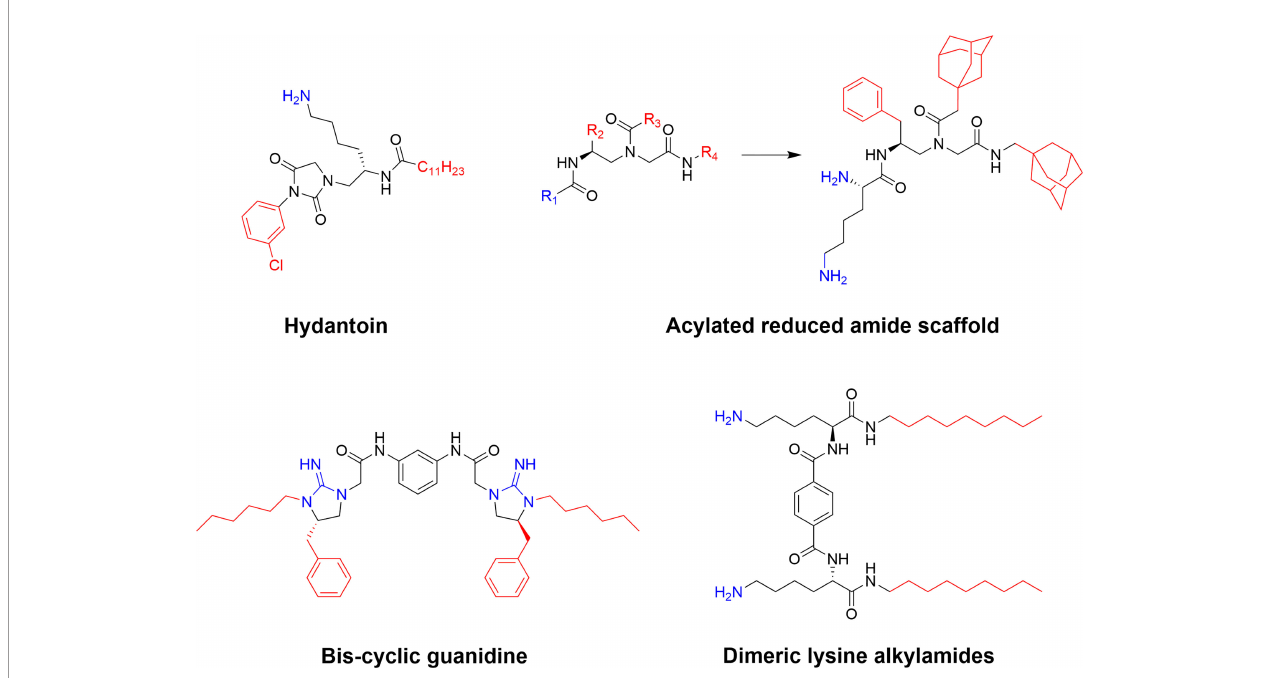
FIGURE 11 | Examples of potent SAMP scaffolds and lead compounds developed by Cai and co-workers (78). Several of these compounds, such as the hydatoin and the cyclic guanidine derivative, display good antimicrobial activity both in vitro and in vivo (143, 144).